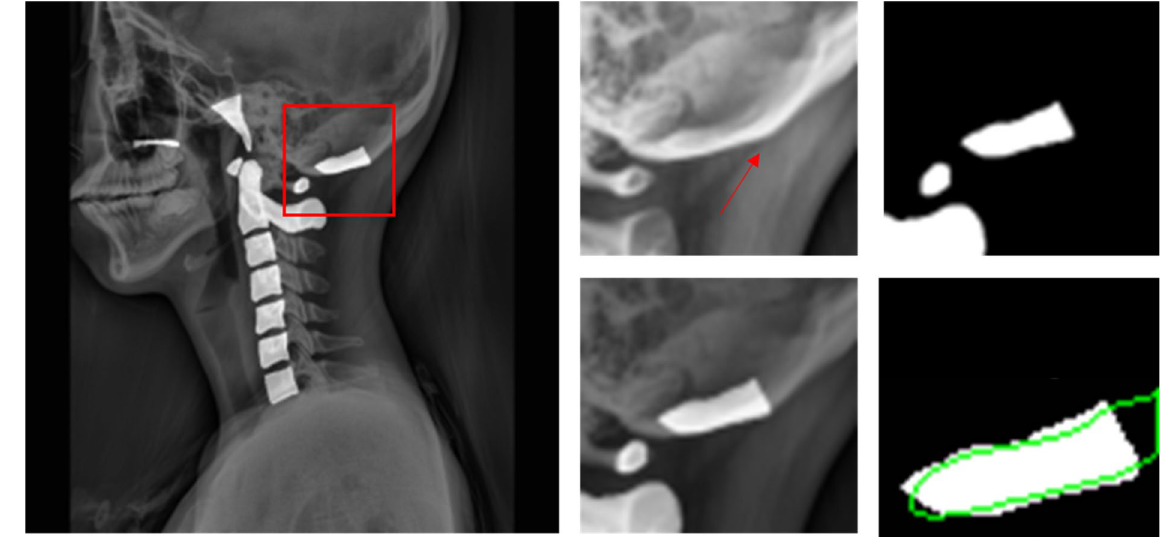
Figure 5. An example of obfuscated boundaries of an opisthion’s posterior end. Red arrow points to the ground truth boundary of the opisthion’s posterior end. The green outline shows an example of an AU-Net predicted opisthion mask, which extends further beyond the ground truth.